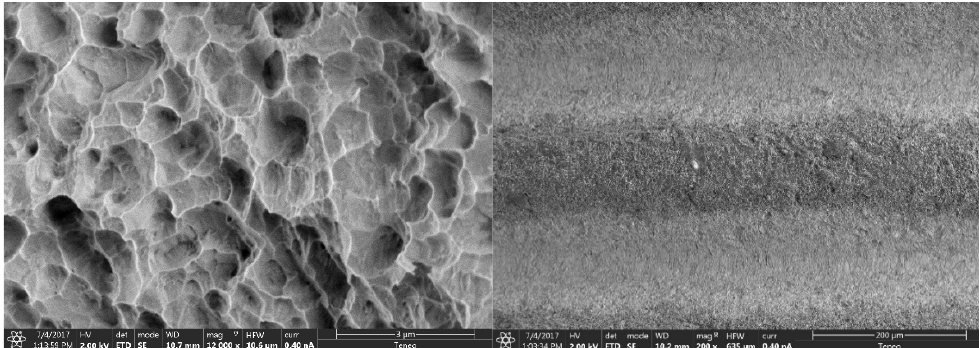
Figure 6. SEM images of the sandblasted and acid etched (SLA) surface 200× ( left ) and 12,000×